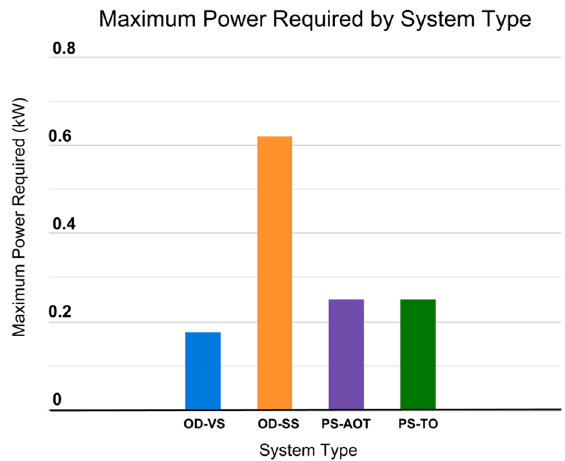
Figure 4. This figure shows the OD-VS model has a maximum power requirement of 0.18 kW, while the OD-SS model has a maximum power requirement of 0.62 kW, the PS-AOT and the PS-TO models both have a maximum power requirement of 0.25 kW.